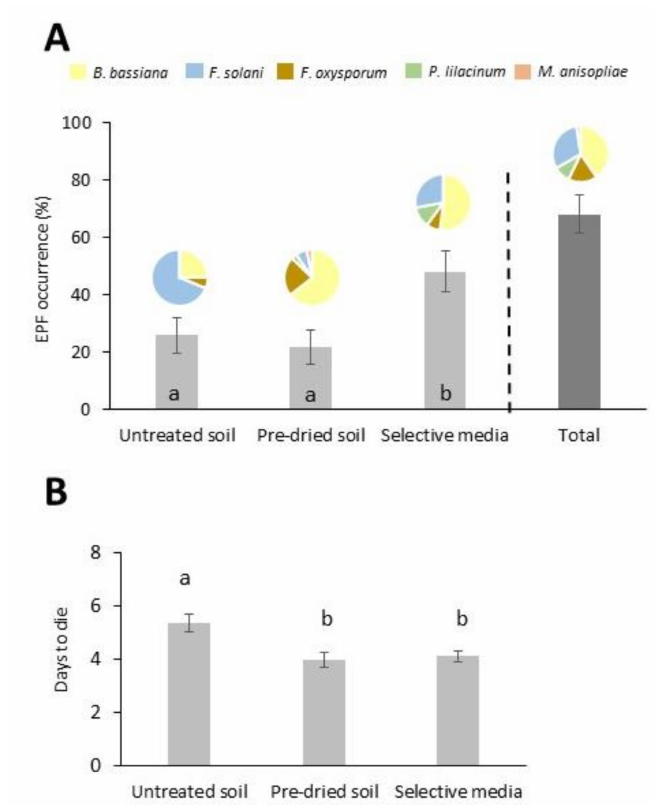
Figure 2. Entomopathogenic fungi (EPF) recorded by using three isolation methods and total EPF recovery (data from all methods combined) ( A ) Recovery frequency in the overall survey. EPF species averages are proportionally represented in pies; ( B) number of days to kill Galleria mellonella larvae by the isolates derived from each of the isolation methods. Data derived from pure cultures in PDA and evaluated by Koch’s postulates test. Di ff erent letters indicate significant di ff erences ( p < 0.05) in Tukey’s test (HSD). Values are least-square means ±